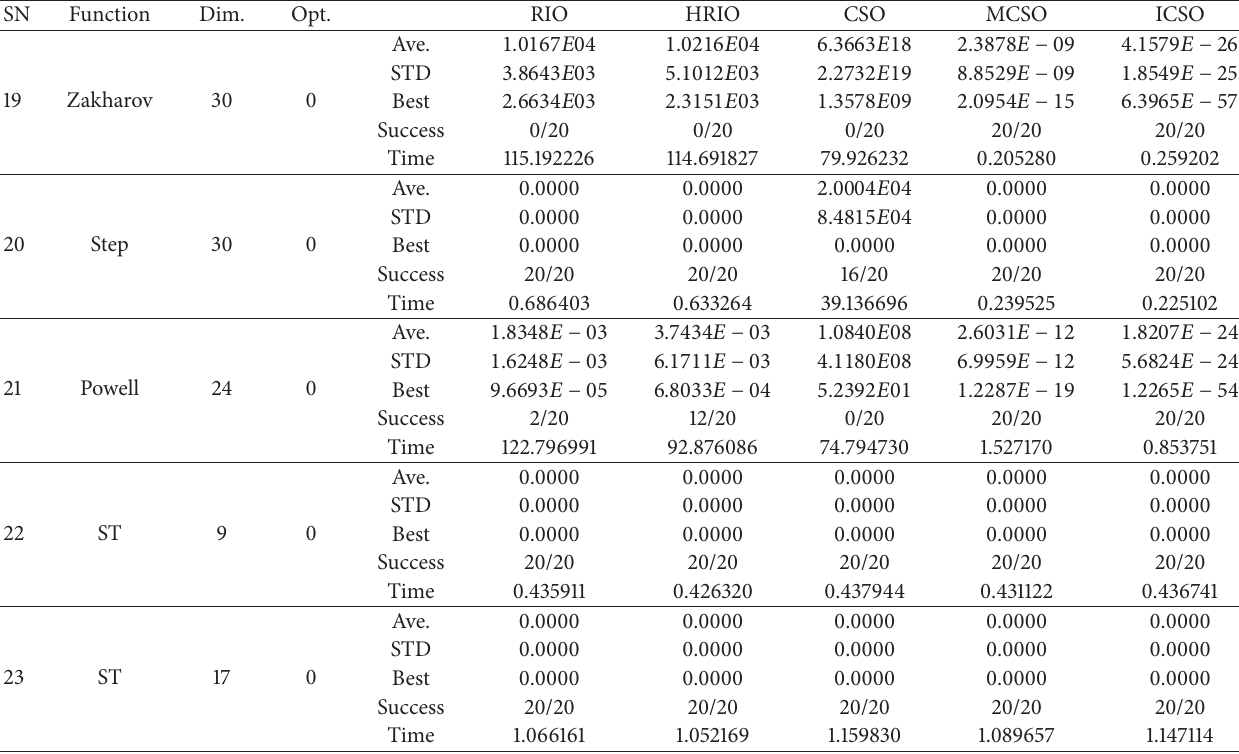
Table 4: Simulation results of RIO, HRIO, CSO, MCSO, and ICSO. SN Function